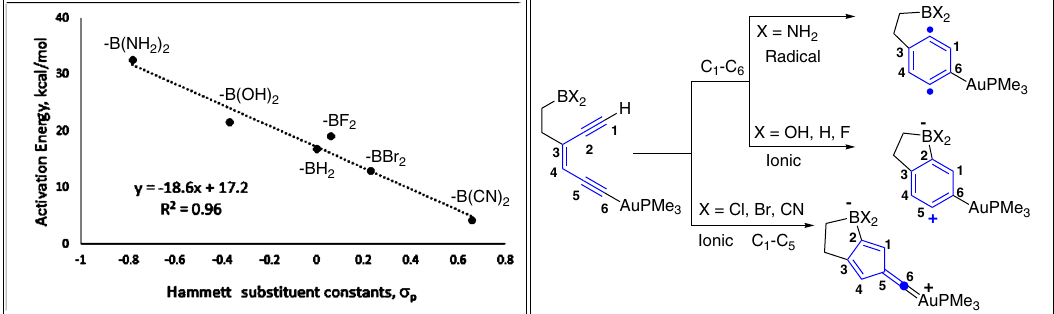
Fig. 11 The scheme on the right show three possible outcomes when enediynes contain both electronically diverse boryl groups and Au(I)-acetylides. The plot on the left shows the dependence of activation energy on the electrophilicity of boryl groups when Au(I)-acetylide contains PMe 3 ligand. All geometries were optimized at the B3LYP/LANL2DZ